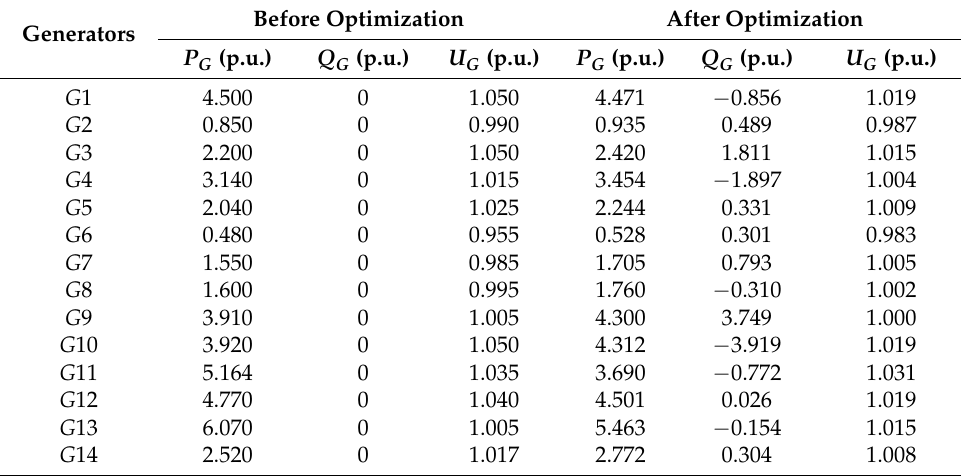
Table 5. Comparison results of generator variables.